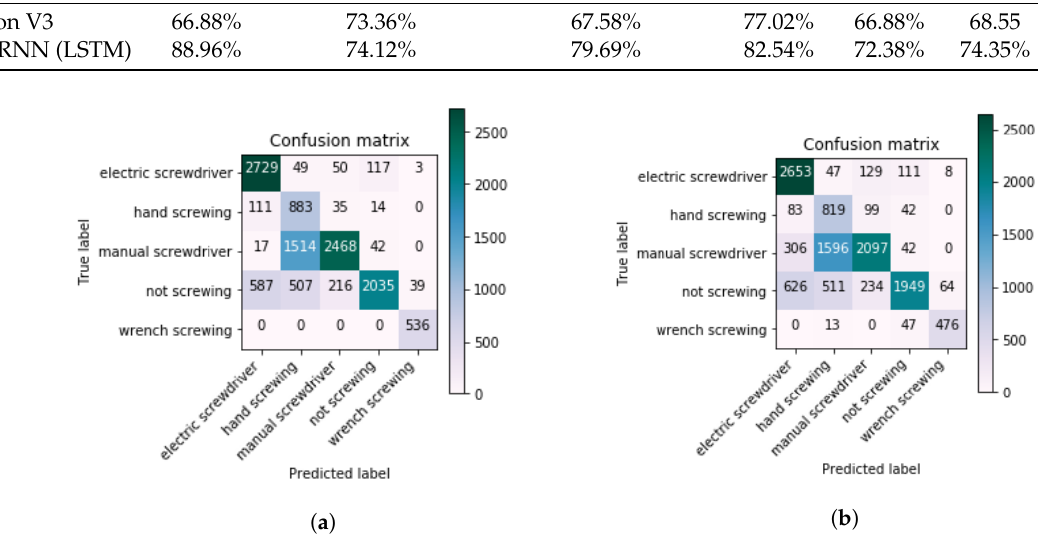
Figure 10. confusion matrices of Inception-V3 and the Inception-V3 with LSTM. ( a ) Final confusion matrices of the Inception-V3 network calculated after fine-tuning on our dataset. ( b ) Final confusion matrices of the Inception-V3 + LSTM network calculated after fine-tuning on our